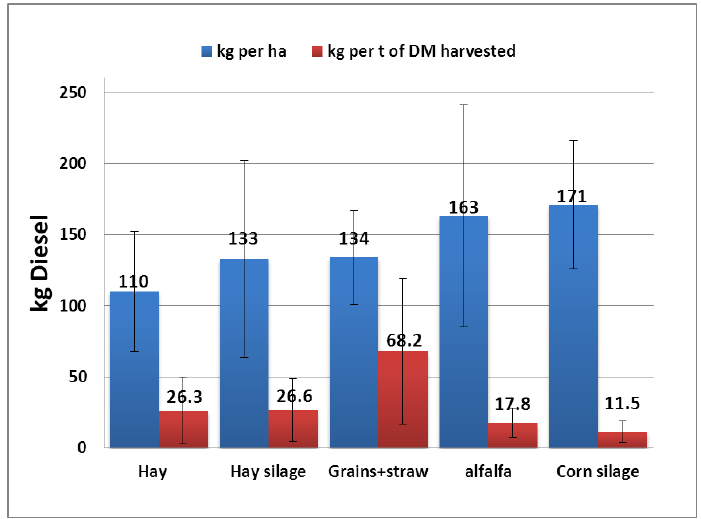
Figure 3. Diesel fuel consumption per cultivated crop and unit of crop harvested.